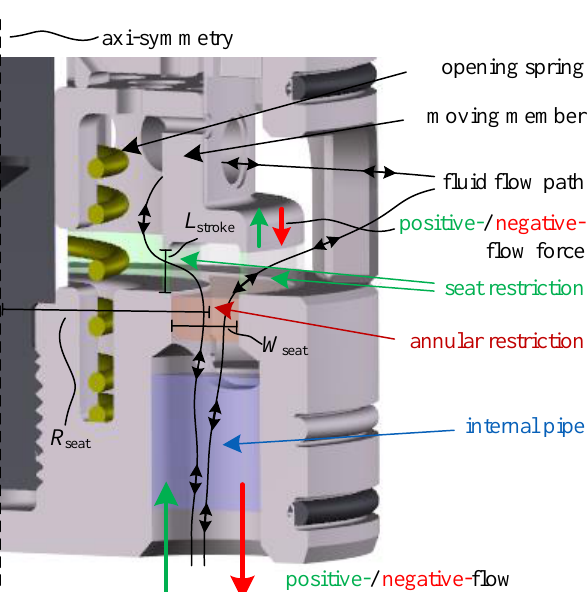
Figure 2: Illustration of the restrictions the Reynolds number is calculated for. The valve design is a moving coil actuated seat valve PT for DDMs, derived in Noergaard et al. (2016). Also, direction of flow and flow forces are defined.